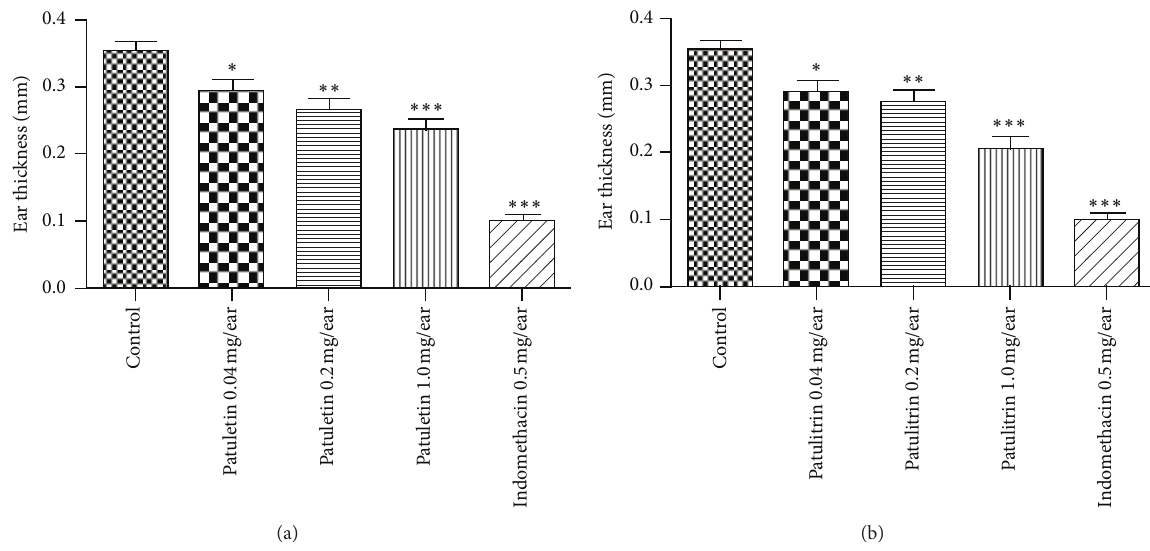
Figure 6: Inhibitory effect of patuletin and patulitrin on TPA-induced ear edema in mice. Drugs were administered topically 30min before TPA (1 𝜇 g). Significantly different from the control, ∗ 𝑃 < 0.05 , ∗∗ 𝑃 < 0.01 , or ∗∗∗ 𝑃 < 0.001 . Each value represents the mean ± SD of 4 mice.